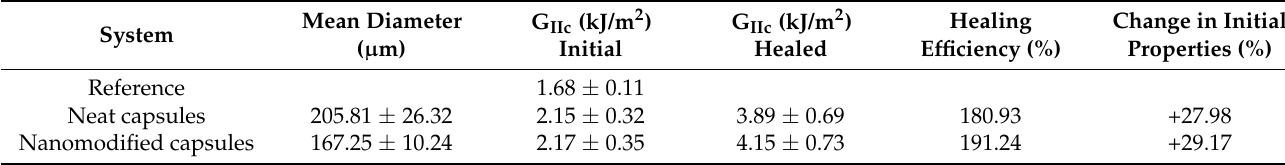
Figure 6. Representative plots of initial (black line) and healed (red line) mode-II specimens containing neat ( left ) and nanomodified ( right ) capsules. Table 1. Healing efficiency and change in initial mechanical properties of mode-II specimens containing neat and nanomodified capsules in terms of G IIc .